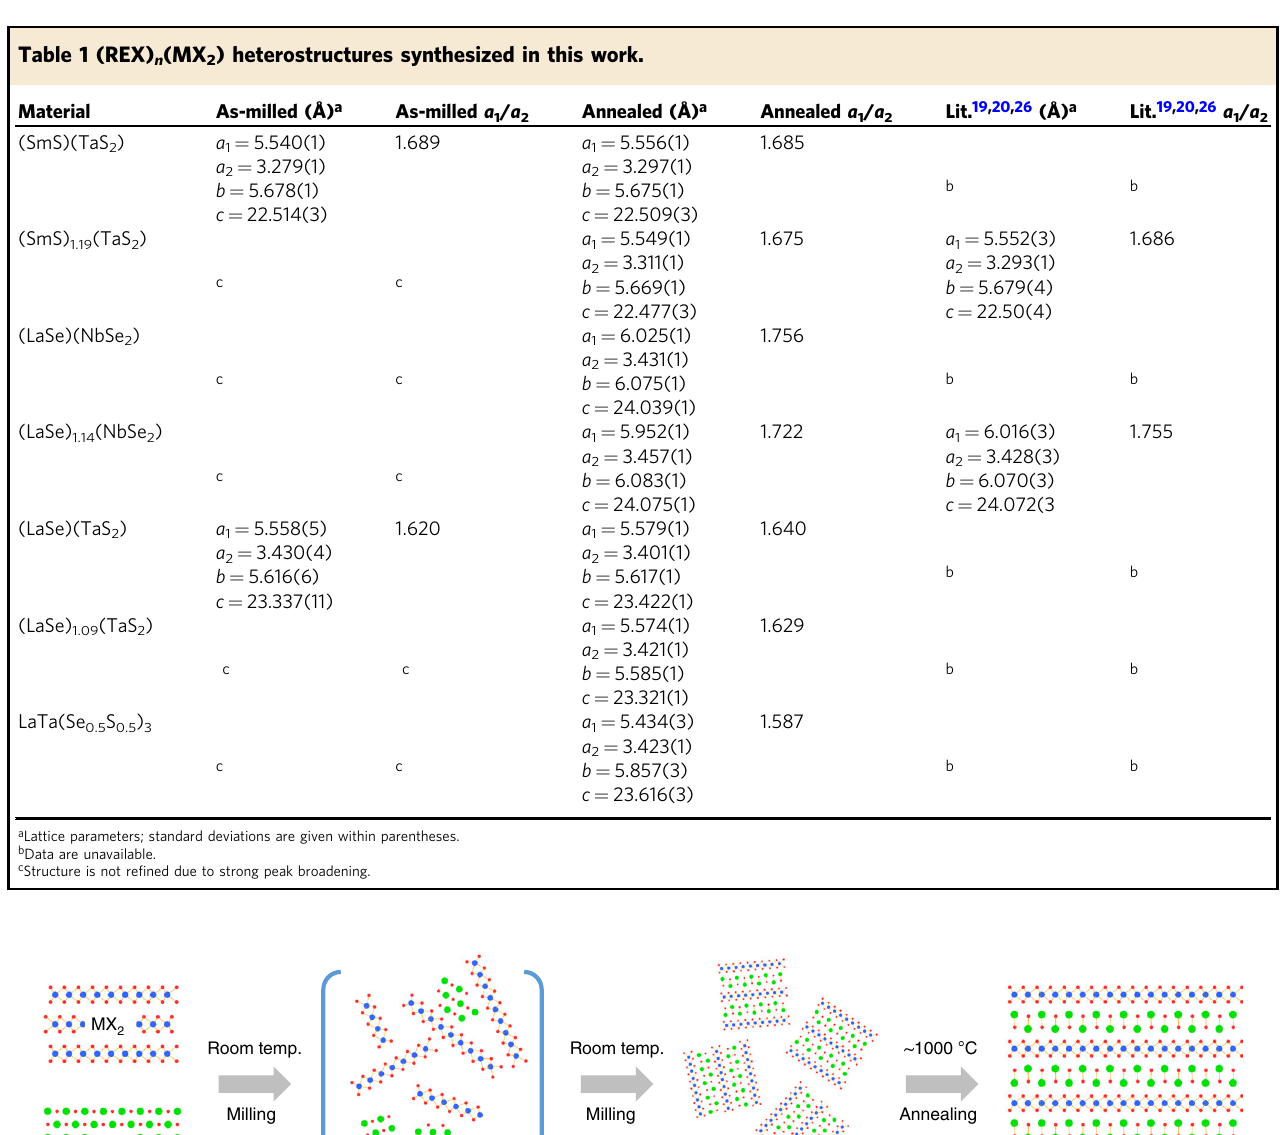
Table 1 (REX) n (MX 2 ) heterostructures synthesized in this work.